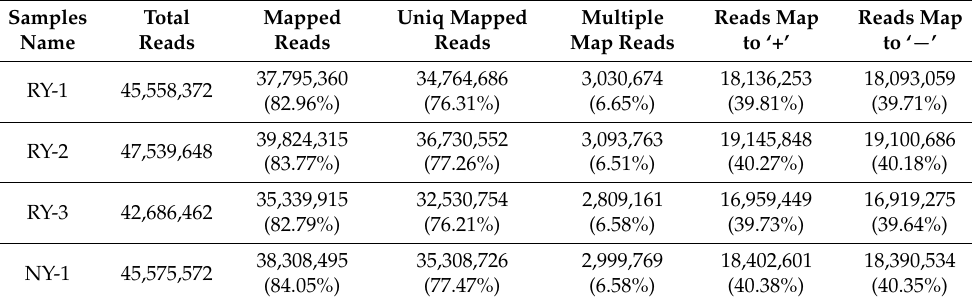
Table 3. Clean reads mapped to the reference